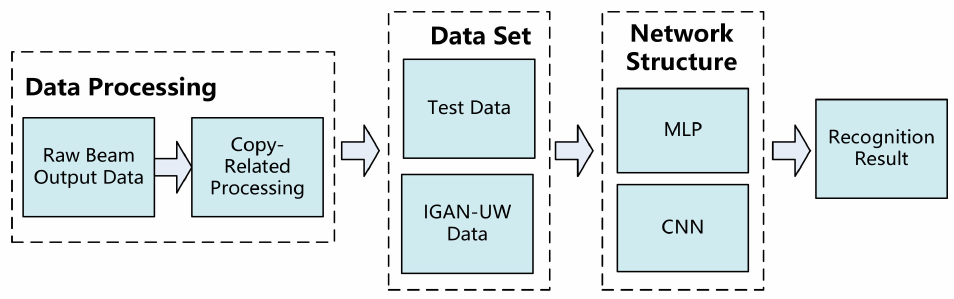
Figure 5. Neural network modeling